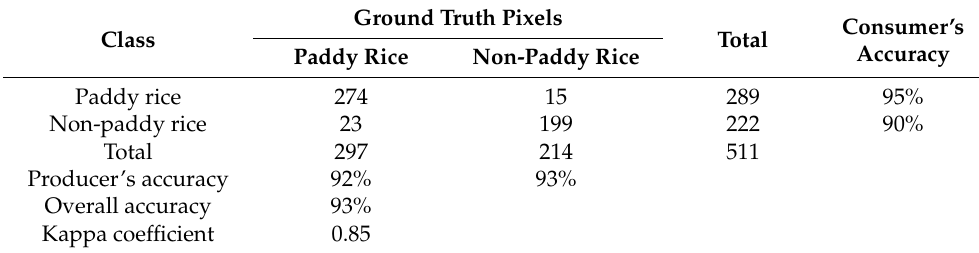
Table 5. Confusion matrix of paddy rice planting area map and field survey points.